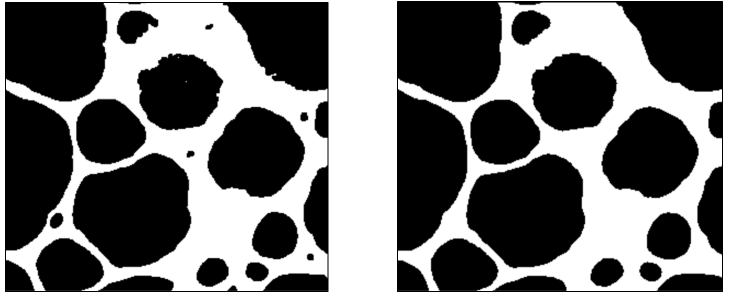
Figure 4. Ideal threshold with no morphological operation ( left ) and ideal threshold for a morpho- logical operation of radius 6 (0.09 mm) ( right ) for the closed-cell foam